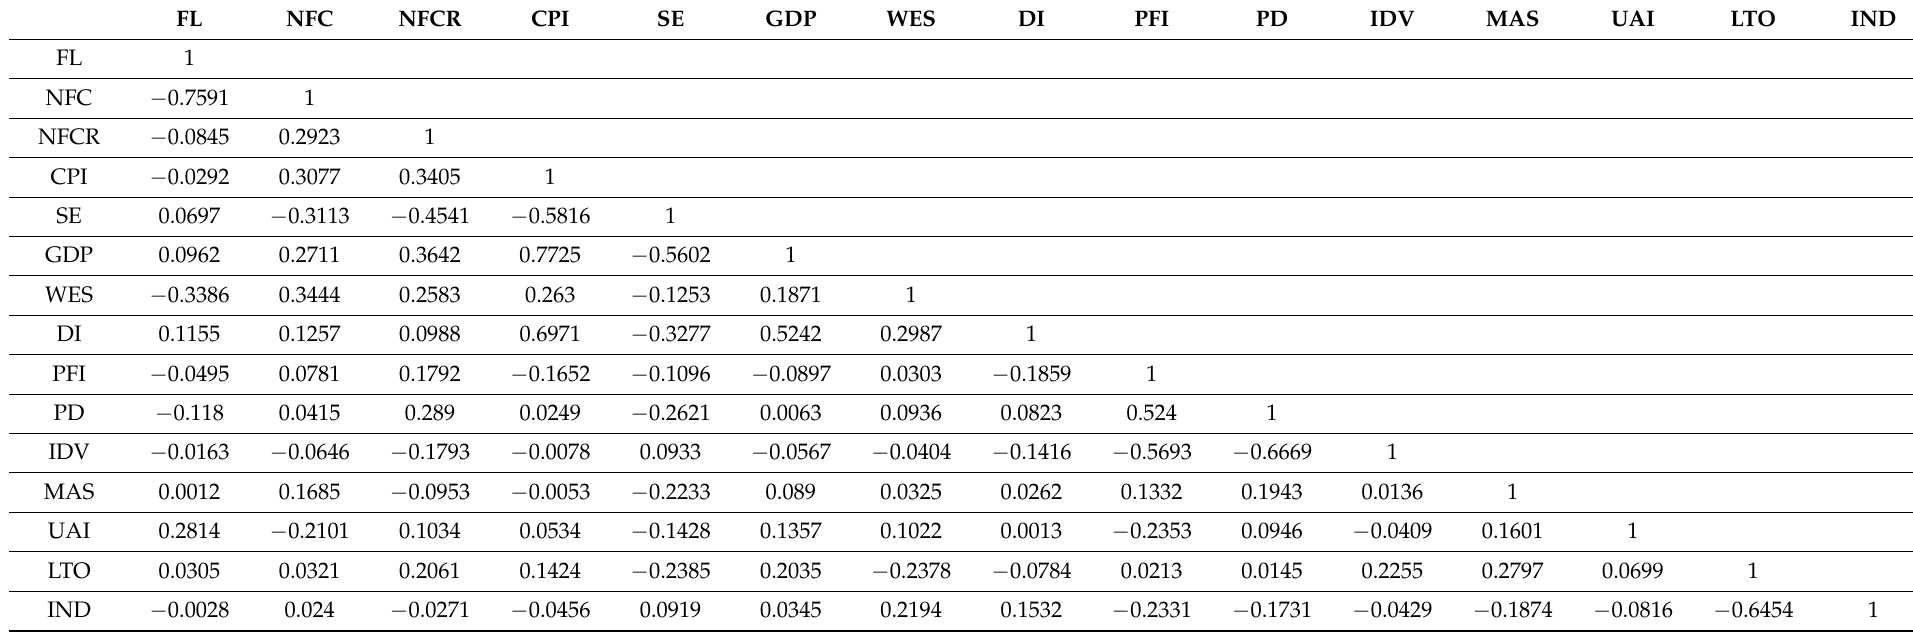
Table 4. Correlation